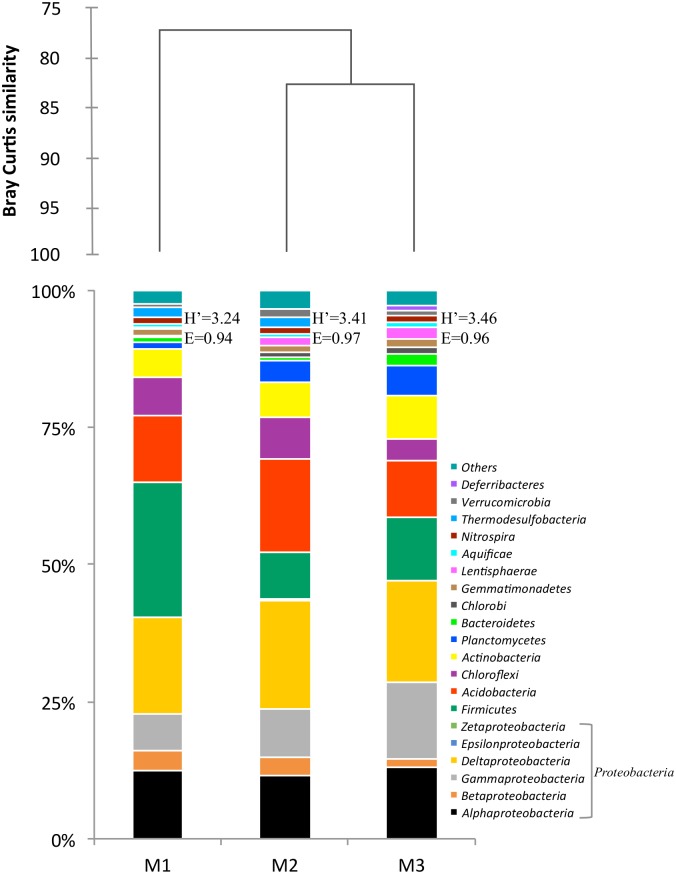
Cluster diagram and relative abundance of sequences (percentage) assigned to bacterial phylogenetic groups and proteobacterial subclasses from sediment samples (M1, M2 and M3) collected from Camarones River.H’: Shannon diversity index, E: Evenness index.